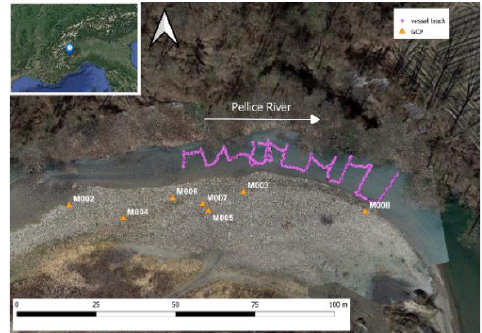
Figure 7. Pellice river orthomosaic map. The orange triangles represent the GCP measured with GNSS receiver, while the purple dots are the points extracted by the vessel-track. summarizes the information relates to the photogrammetric survey for each case study.